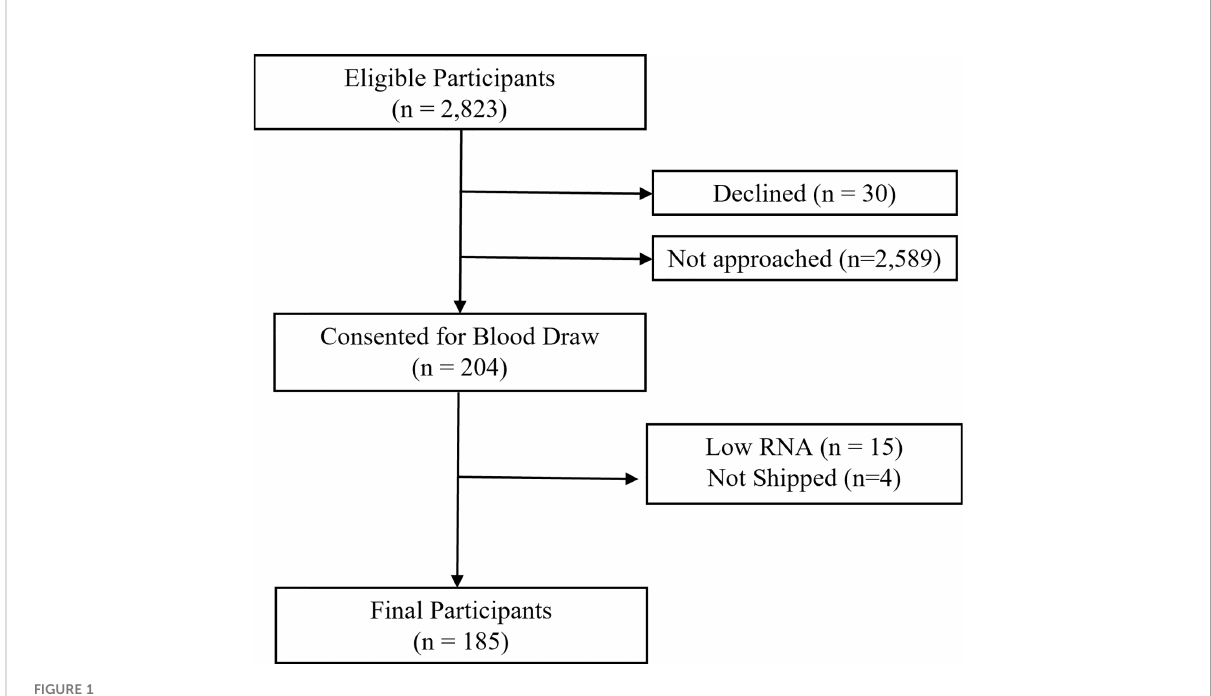
FIGURE 1 Participant fl